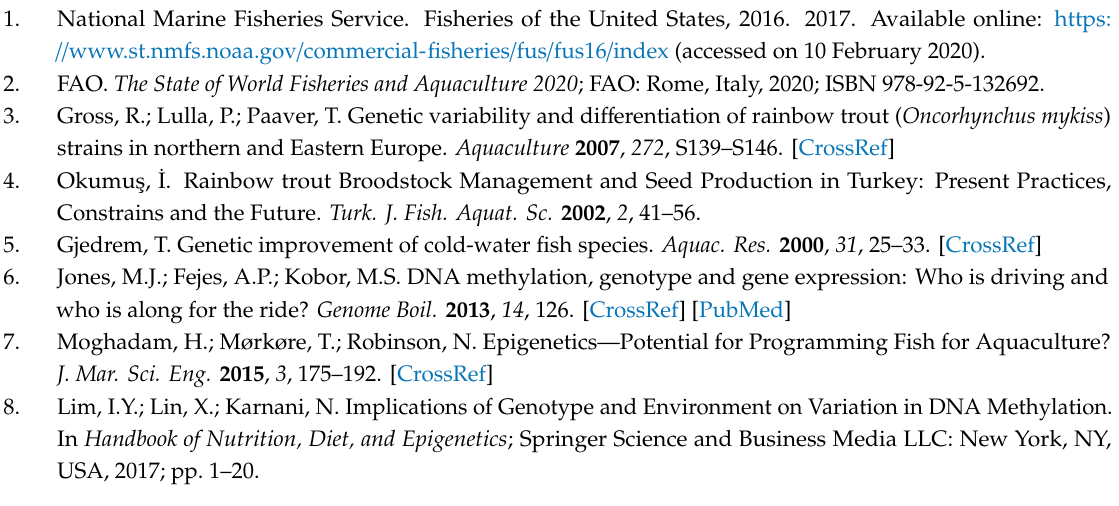
Table S1: RIN values of RNA samples used for library preparation. Table S2: Primers used for SNP validation. Table S3: Lists of di ff erentially expressed genes across all tissues and identified putative SNPs within di ff erently expressed (DE) genes. Table S4: List of detected putative SNPs distinguishing the breeding strains. Table S5: Table S6: Number of putative SNPs per tissue by length of protein-coding transcripts (A1). Figure S1: Venn diagram illustrating the identified SNPs that are common or exclusive to the six